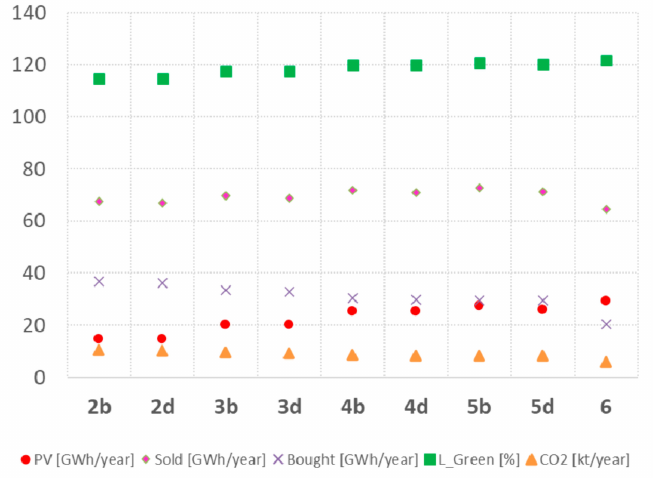
Figure 5. Key performance indicators when the installed wind capacity is increased of 50